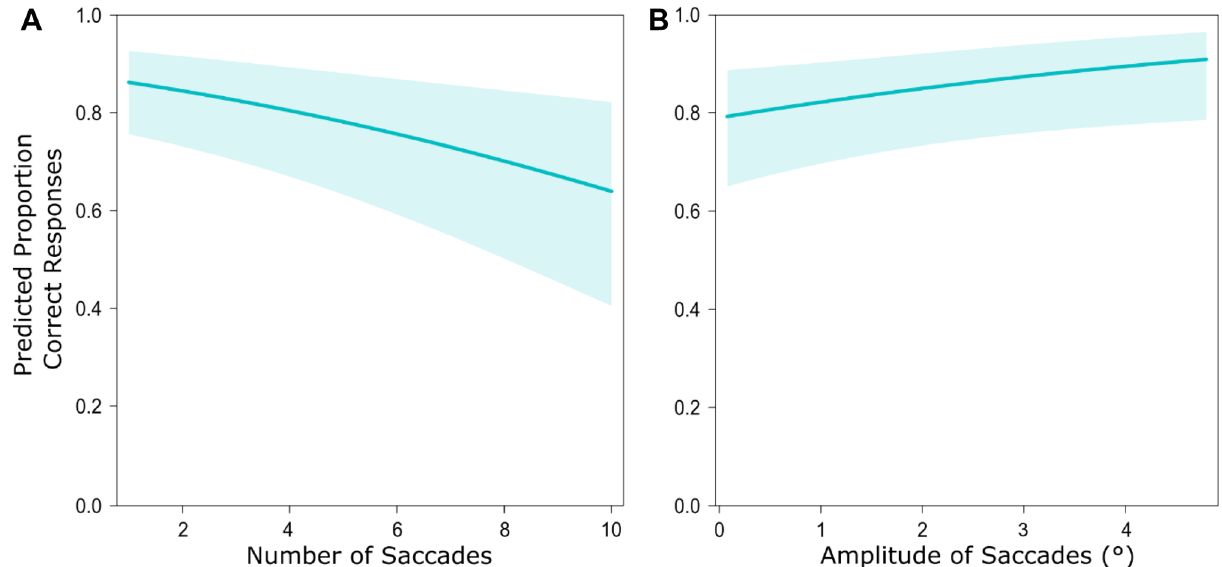
Figure 7. Effects of gaze behavior towards the comparison vehicle on discrimination performance. Panels depict the predicted proportion of correct responses in the time-to-arrival discrimination task by ( A ) the number saccades and ( B ) the amplitude of saccades. Shaded areas represent the 95% confidence